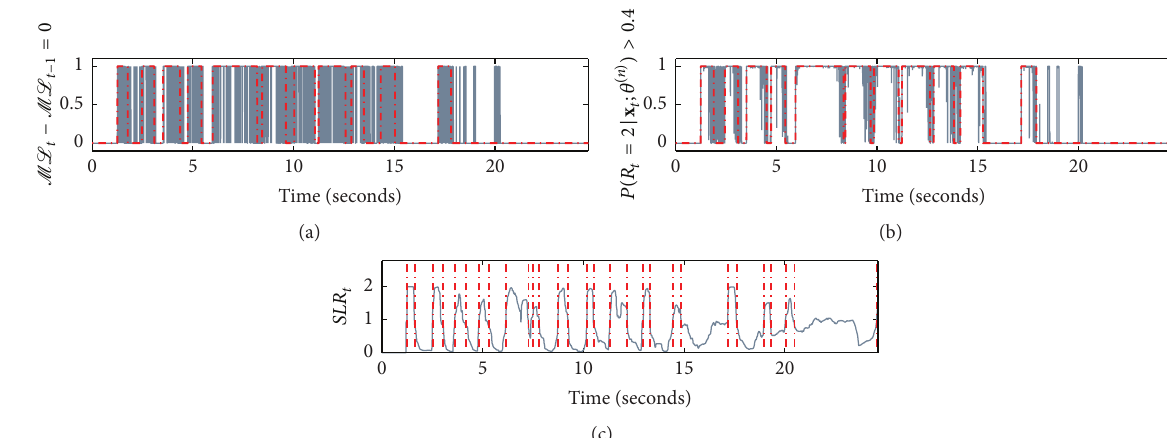
Figure 14: The application of the discussed methods to real dataset containing several seismic events. The final segments have been marked by using bold red-dashed curves. (a) The application of the smoothing procedure used for segmentation purposes based on ML 𝑡 statistics. The grey curve depicts the nonsmoothed segments. (b) The application of the smoothing procedure to the vector of probabilities of being in the second regime with the boundary threshold set to 0.4. The grey curve denotes the nonsmoothed vector of probabilities. (c) Sequence of the test statistics 𝑆𝐿𝑅 𝑡 , where the short and long time windows are equal to 0.3 s and 1.2s, respectively; the activation 𝜏 𝐴 and deactivation 𝜏 𝐷 thresholds correspond to 1.1 and 0.8, respectively.